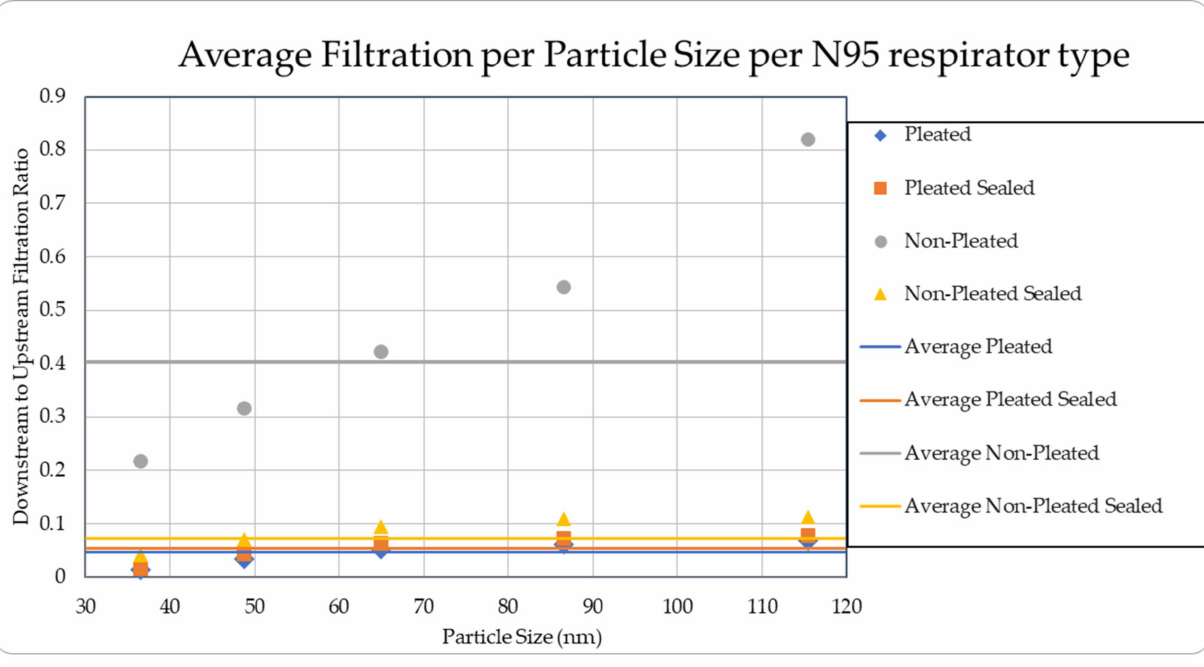
Figure 6. Average filtration ratios per type and per particle size at the Die Casting